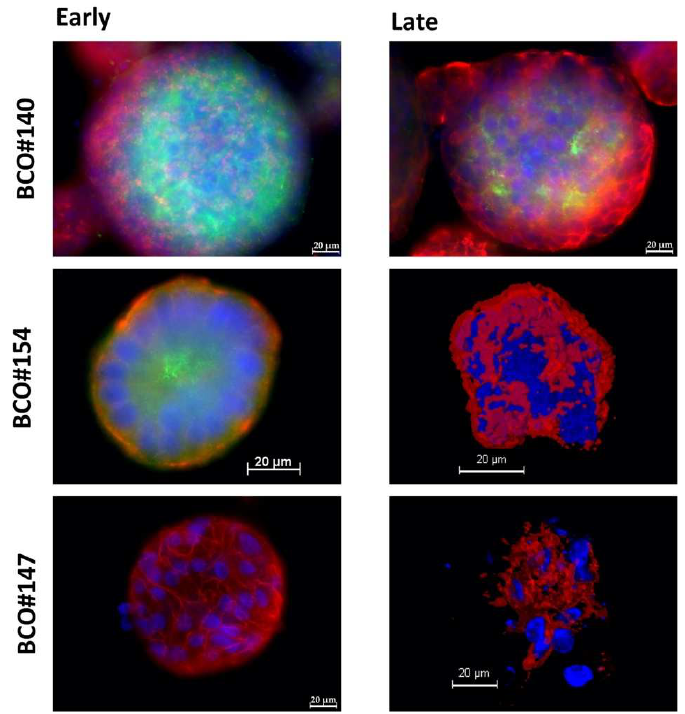
Figure 7. Expression of CD24 and CD44 on organoids. Organoids of BCO#140, #154, and #147 were fixed and stained with primary antibodies reactive with bladder cancer stem-cell markers CD24 and CD44. Expression of CD24 was visualized by a green fluorescent AlexaFluor488-labelled detection antibody. CD44 was visualized by a red fluorescent Cy3-labelled detection antibody. Cell nuclei were stained by DAPI. Table 4. Expression of stem-cell markers on organoids of BC in chamber slides 4 .